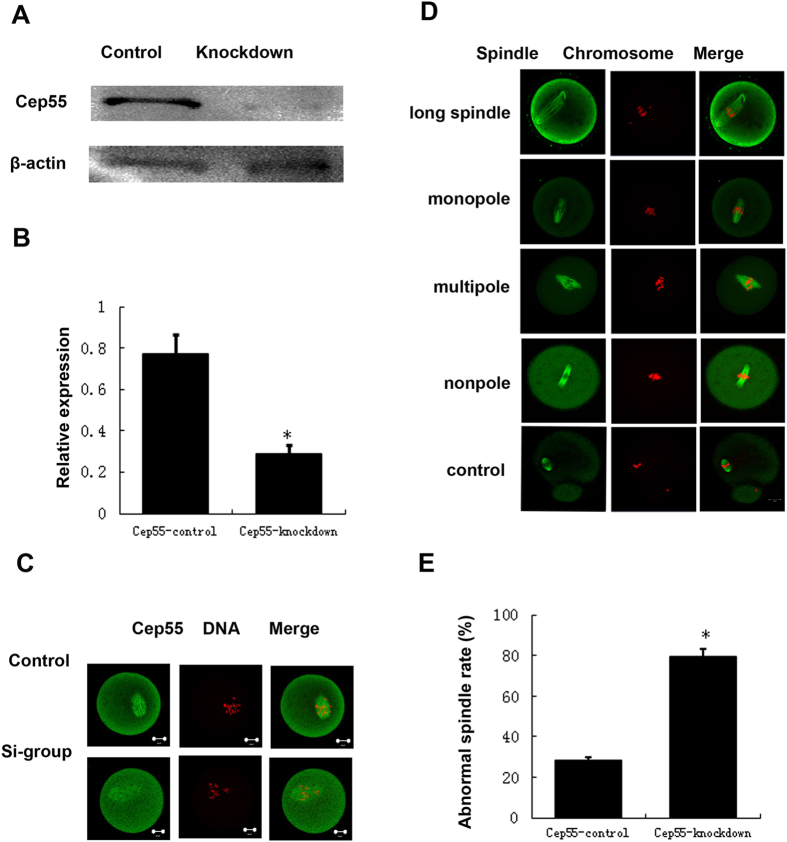
Depletion of Cep55 causes severely abnormal spindle and misaligned chromosomes in oocytes.(A) Western blotting showing knockdown of Cep55 protein after siRNA. After microinjection of Cep55 or control siRNA, the oocytes were incubated in M16 medium containing 200 μM IBMX for 24 h, then washed 9 times and placed in IBMX-free M16 medium for 6 h, followed by western blotting. The molecular weights of Cep55 and beta-actin are 55 kD and 43 kD, respectively. A total of 200 oocytes were used in each lane. (B) Relative expression of Cep55 after siRNA treatment. Data are presented as means + -SEM of 3 independent experiments (p < 0.05). (C) Confocal image showing knockdown of Cep55 protein after siRNA. After microinjection of Cep55 or control siRNA, the oocytes were incubated in M16 medium containing 200 μM IBMX for 24 h, then washed 9 times and placed in IBMX-free M16 medium for 4 h. A total of 132 oocytes were assessed in the si-group and 143 oocytes were assessed in the control group. (D) After microinjection of Cep55 or control siRNA, the oocytes were incubated in M16 medium containing 200 μM IBMX for 24 h, then washed 9 times and placed in IBMX-free M16 medium for 14 h of culture, followed by immunostaining with α-tubulin (green) and Hoechst 33342 (red). In the Cep55-depletion group, the oocytes showed various kinds of severely abnormal spindles and misaligned chromosomes. Bar = 20 μm. (E) The rate of oocytes with abnormal spindles and misaligned chromosomes in the Cep55 depletion group and control group. Data are presented as means + -SEM of 4 independent experiments (*p < 0.05).